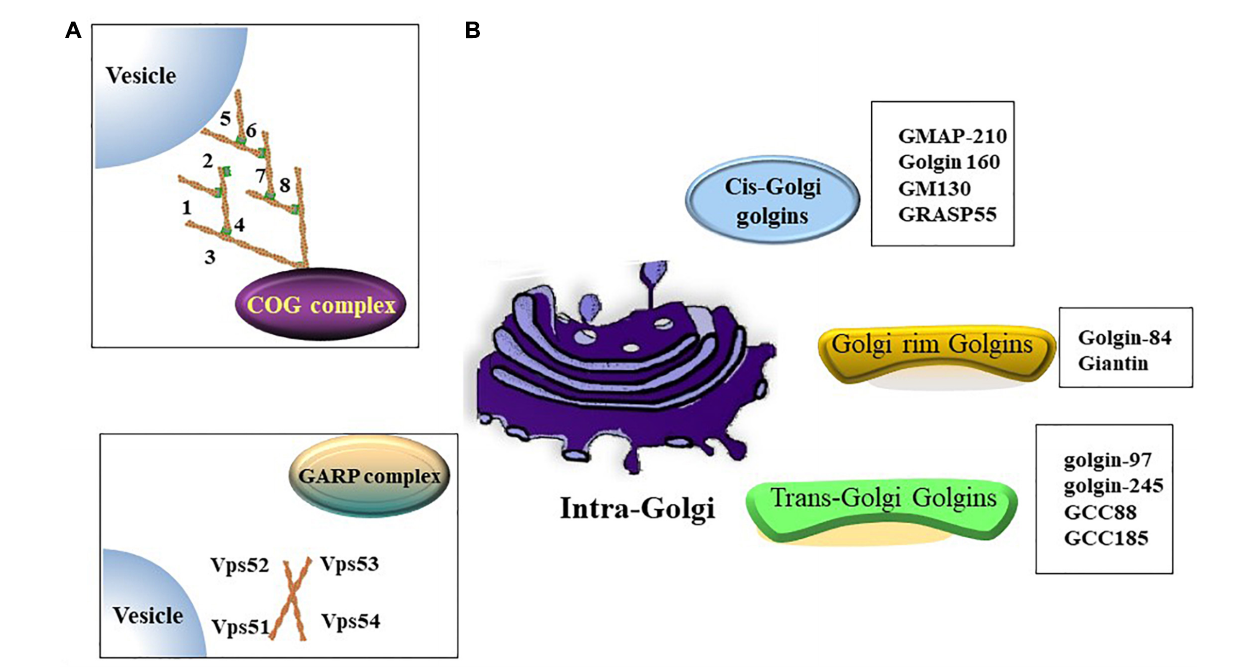
FIGURE 1 | Golgi proteins involved in vesicles transportation. (A) Both of oligomeric Golgi (COG) complex (comprised of Cog1-8) and Golgi-associated retrograde protein (GARP) complex (comprised of VPS51, VPS52, VPS53 and VPS54) are tethering complex that functions as cargo trafficking complex. (B) A summary of golgins in different